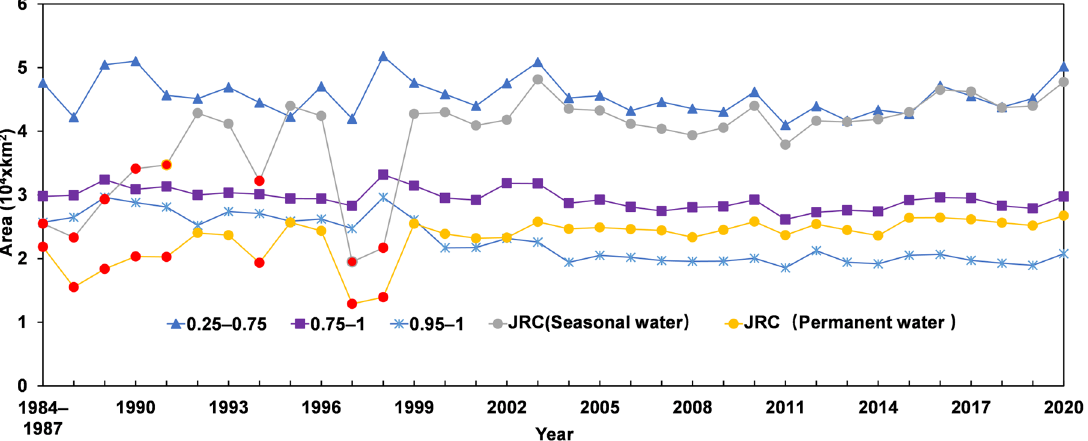
Figure 10. Comparison of the MLYP’s yearly open water body area with the JRC v1.3 data (the red dots in the figure represent the yearly data of the JRC errors in the MLYP ) .